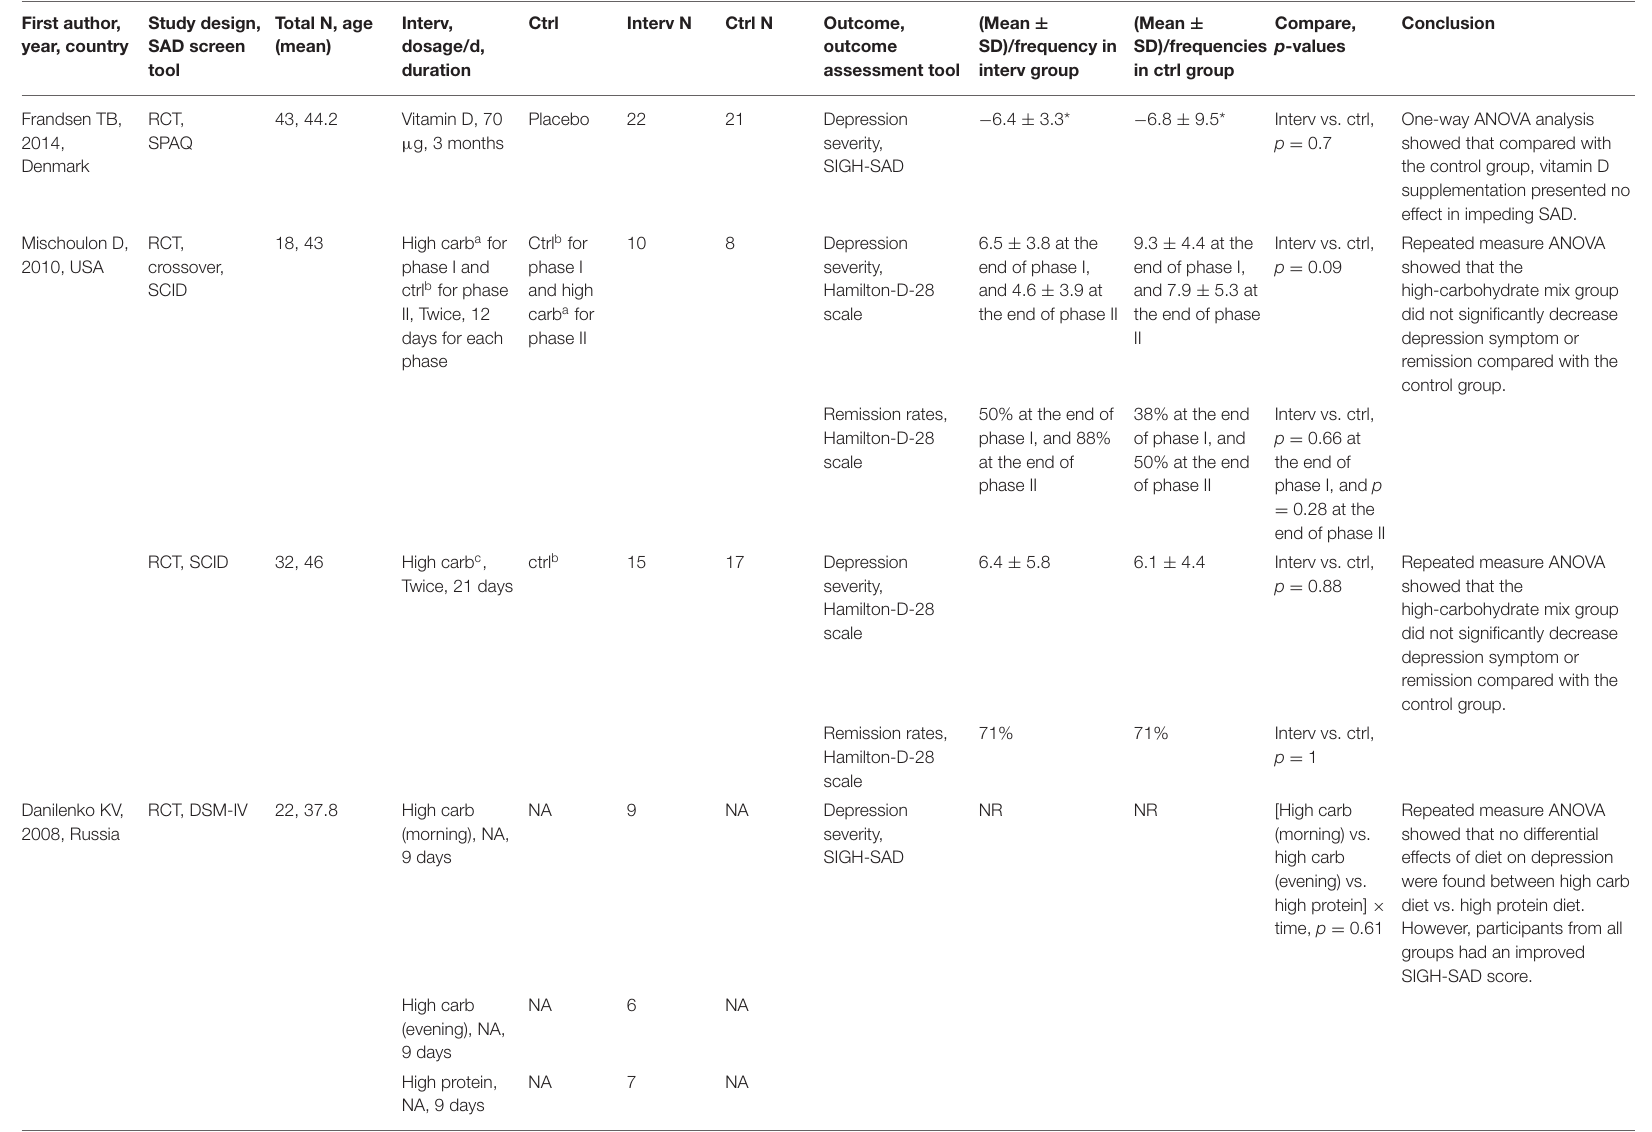
TABLE 3 | Characteristics of included studies evaluating the associations between nutrition intervention and